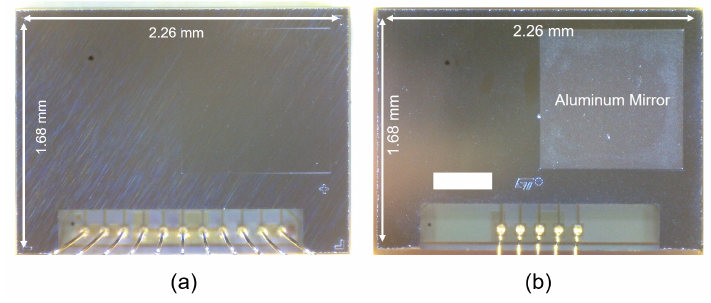
Figure 8. Micrograph of ( a ) the proposed thermopile and ( b ) TMOS